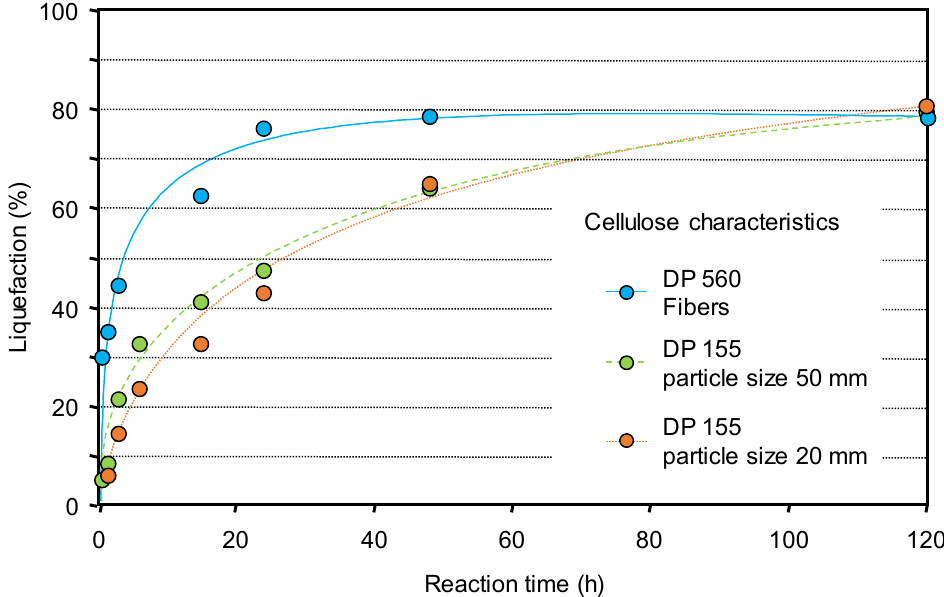
Figure 1. Non-catalyzed liquefaction of celluloses of different characteristics (water 60 mL, Avicel and Sigmacell celluloses 2 g, 190 °C). Liquefaction was determined by the difference between the initial and residual mass of cellulose. Adapted from [56].